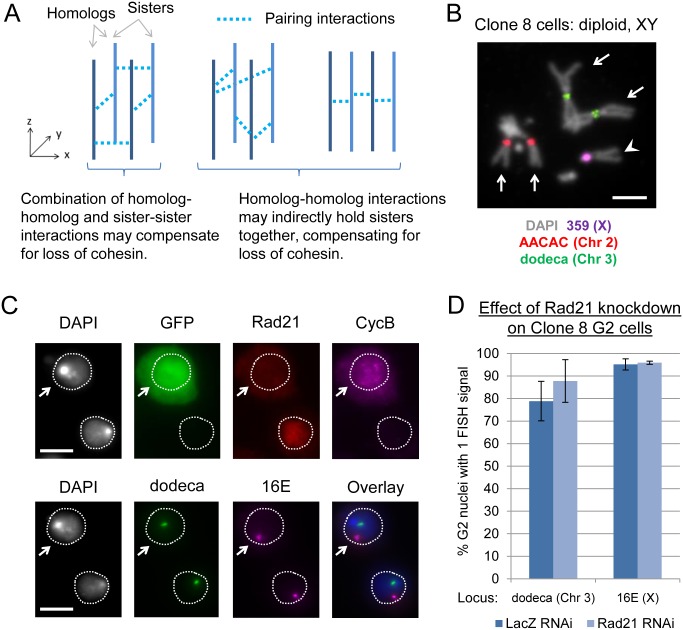
Interphase cohesion between sister chromatids following cohesin knockdown does not require the presence of a homolog.(A) Cartoon showing theoretical interactions between chromosomes. Homologs and sister chromatids can be held together by a combination of homolog-homolog and sister-sister interactions (left) or just homolog-homolog interactions that indirectly hold sister chromatids together (middle, right). (B) Karyotype of Clone 8 cells, which have two copies of the autosomes (long arrows) and a single X chromosome (arrowhead). Scale bar = 5 μm. (C) Clone 8 cells following Rad21 knockdown (top row, immunofluorescence; bottom row, FISH). GFP serves as a marker for cells transfected with dsRNA, while Cyclin B (CycB) indicates cells in the G2 stage of the cell cycle. The cell marked by the arrow is in G2 and depleted for cohesin, but FISH indicates that sister chromatid cohesion is unperturbed, both for an autosome (dodeca, 3rd Chr.) and for the X chromosome (16E). Scale bar = 5 μm. (D) Quantification of results for experiment illustrated in (C) showing percentages of nuclei with a single FISH signal at dodeca and 16E. Means represent three independent trials; error bars = SD; n≥40 per trial per knockdown. Differences between control and Rad21 knockdown cells were not significant by Fisher’s exact test (P = 0.0654 and P = 0.7992 for dodeca and 16E, respectively).